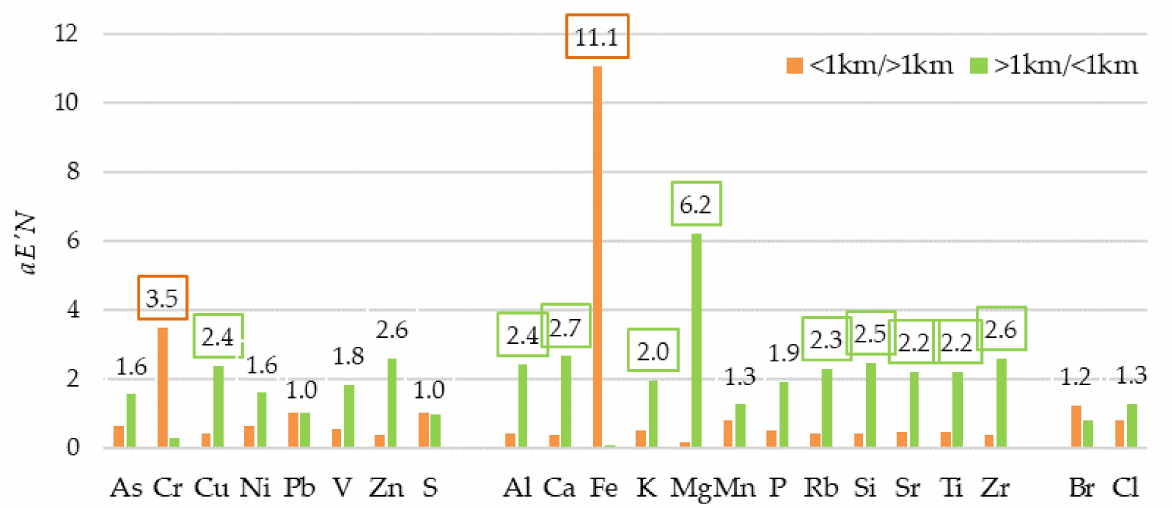
Figure 12. Ratios of median elemental aE’N values in two areas. Legend: <1 km/>1 km (in brown) indicates accumulation of analytes in iron ore stevedoring dust in the <1 km area, while >1 km/<1 km (in green) their accumulation in the rest part of the city. The value of ratio is in outline, if U-test shows significant ( p < 0.05) difference between the areas in the values of the index.